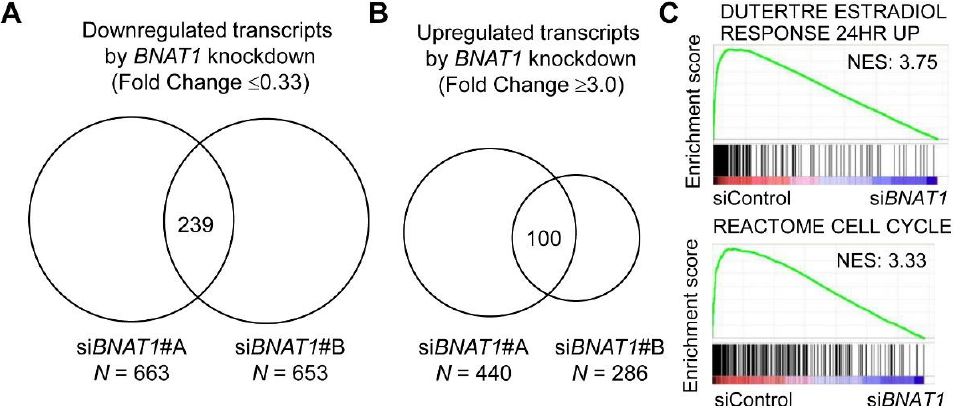
Figure 4. Differentially expressed transcripts in MCF7 cells treated with BNAT1 -specific siRNAs versus control siRNA. ( A ) Downregulated transcripts by si BNAT1 #A or #B versus siControl with a fold change ≤ 0.33. ( B ) Upregulated transcripts by si BNAT1 #A or #B versus siControl with a fold change ≥ 3.0. ( C ) Gene Set Enrichment Analysis (GSEA) plots for dominant pathways in MCF7 cells treated with si BNAT1 s #A and #B versus siControl, including the signaling for estradiol response and endocrine therapy resistance. Table 5. Top 5 Gene Ontology (GO) terms among 239 commonly downregulated transcripts by si BNAT1 #A and #B.